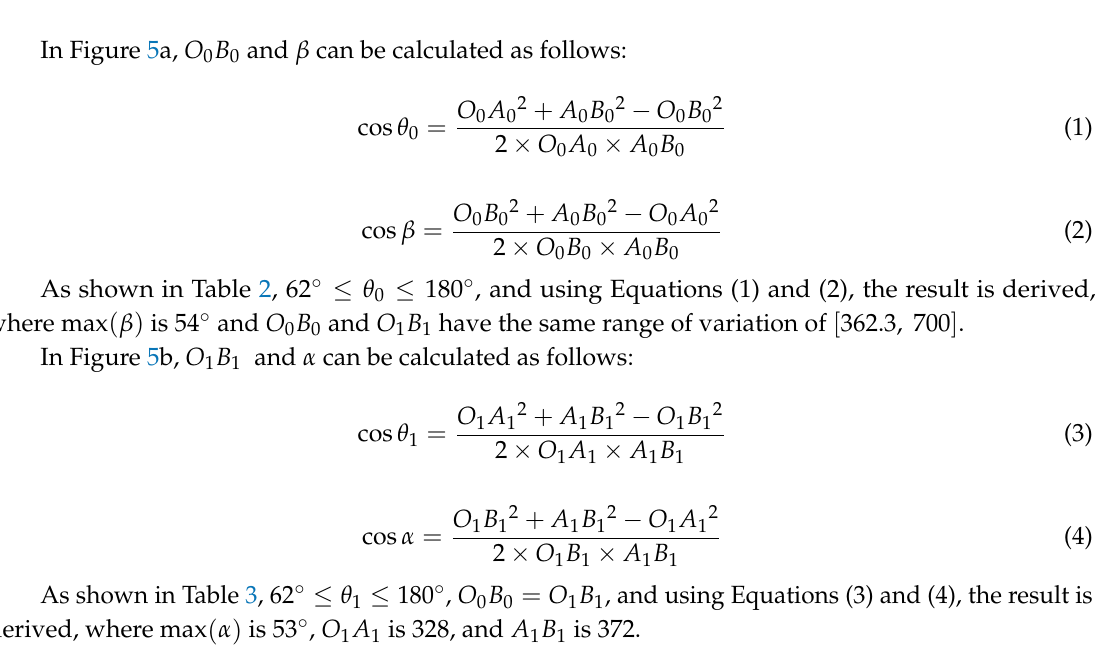
Figure 5. Distance between the end ‐ effector and shoulder joint: ( a ) 5 ‐ DOF upper ‐ limb exoskeleton; and ( b ) 3 ‐ DOF upper ‐ limb exoskeleton.